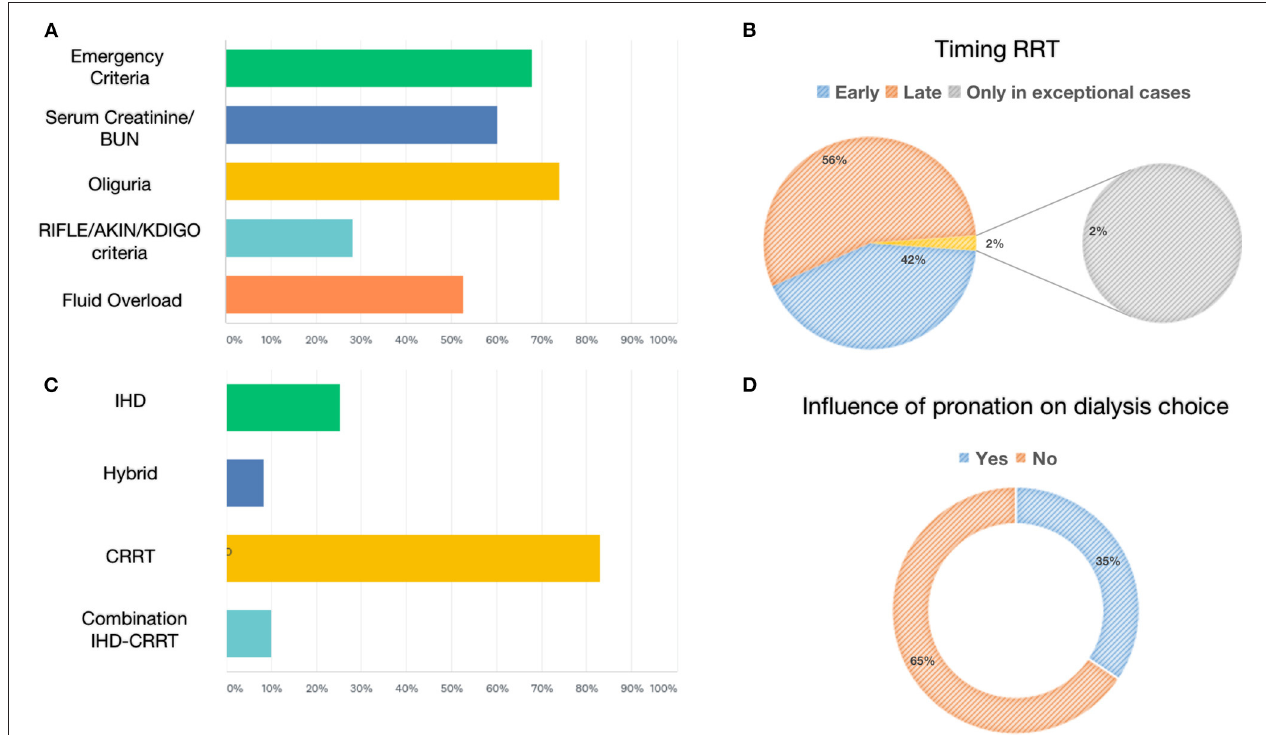
FIGURE 2 | Renal replacement therapies: indication, modality, timing, and prone positioning influence. (A) Shows the percentage of parameters used to define the indication to start RRT. (B) Shows the percentage of early vs. late initiation of RRT. (C) Shows the percentage of RRTs for AKI. (D) Shows the percentage influencing the choice of dialytic strategy due to prone